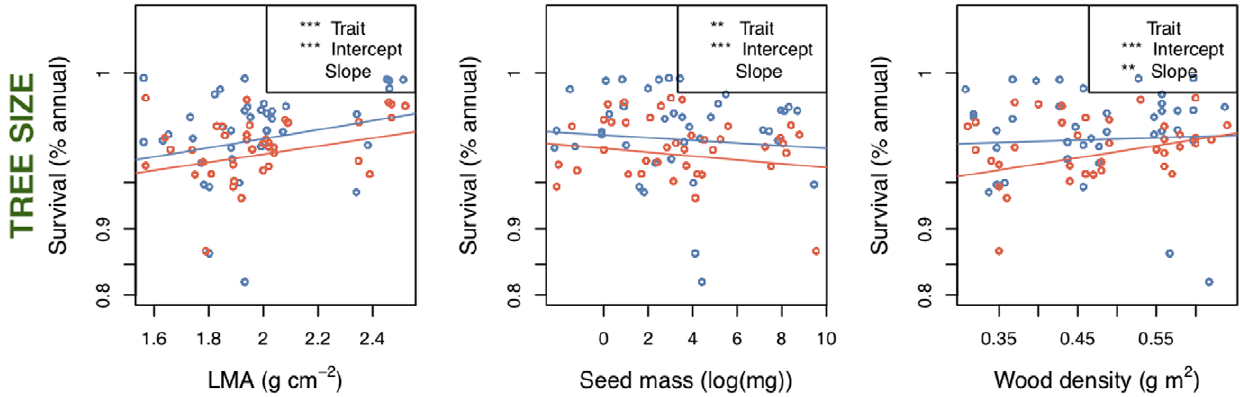
Figure 3. Survival versus functional traits with ontogenetic variable as a covariate. LMA and seed mass shows a difference between intercepts, while wood density shows no overall slope (see Figure 2 panel 3), but the interaction term shows a differential survival between large and small trees depending on wood density, with smaller trees showing an effect of wood density. Slope for large trees is blue and for small trees red. ANOVA table details in Table 1. Significance codes for all figures: 0 ‘***’ 0.001 ‘**’ 0.01 ‘*’ 0.05 ‘.’ 0.1 ‘ ’ 1.